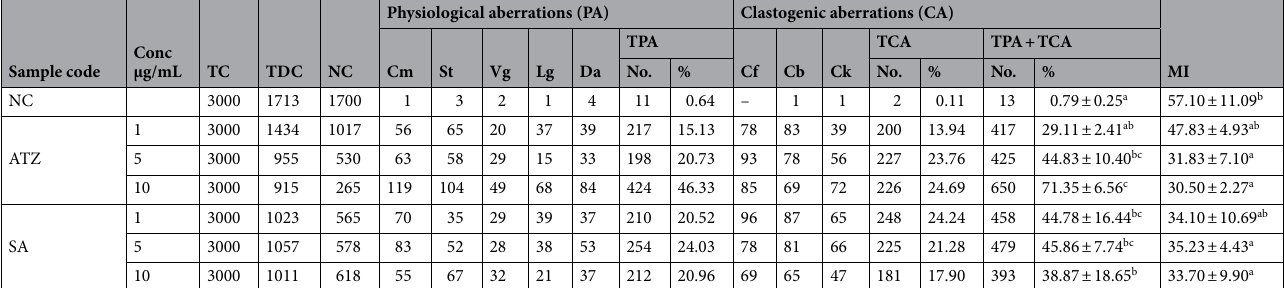
Table 5. Chromosomal aberrations observed in Allium cepa roots cells treated with different concentrations of atrazine and sodium azide. NC negative control, ATZ atrazine, SA sodium azide, TC total cells, TDC total dividing cells, NC normal cells, Cm C-mitosis, St stickiness, Vg vagrant, Lg laggard, Da delayed anaphase, Cf chromosome fragments, Cb chromosome bridge, Ck chromosome break, TPA total physiological aberration, TCA total clastogenic aberrations, MI mitotic index. Data are mean ± SD of three replicates. Different alphabets (a, b and c) are significantly different at (p < 0.05), as determined by Tukey HSD